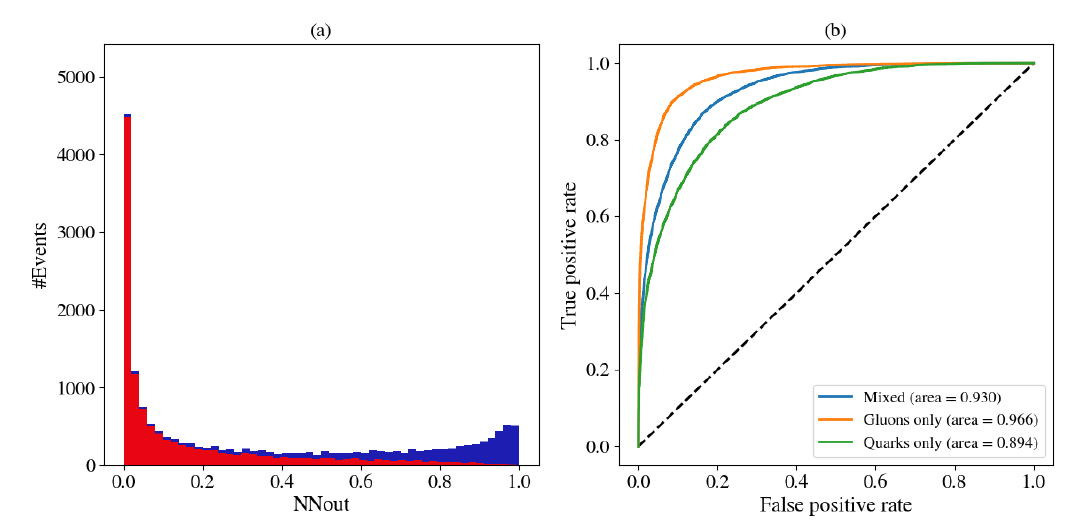
Figure 2: (a) Output of the neural network for signal (blue) and background (red). (b) ROC curves for the network.